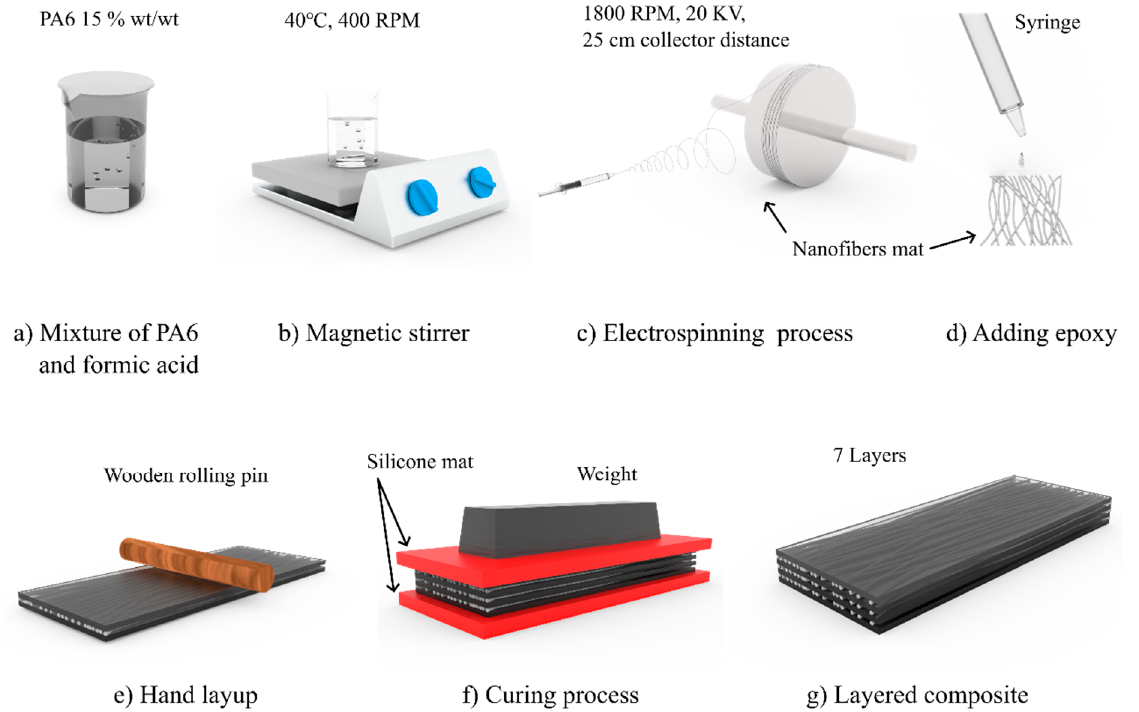
Figure 1. The fabrication process of the layered composite. ( a ) preparation of PA6 granules and formic acid mixture; ( b ) Magnetic stirrer of mixture at 40 ℃ at 400 RPM; ( c ) Fabrication of electrospun nanofibers; ( d ) Appling epoxy to nanofiber mat ( e ) Hand layup to avoid voids between the layers; ( f ) epoxy curing process under the pressure between the silicone mat; ( g ) layered nanocomposite